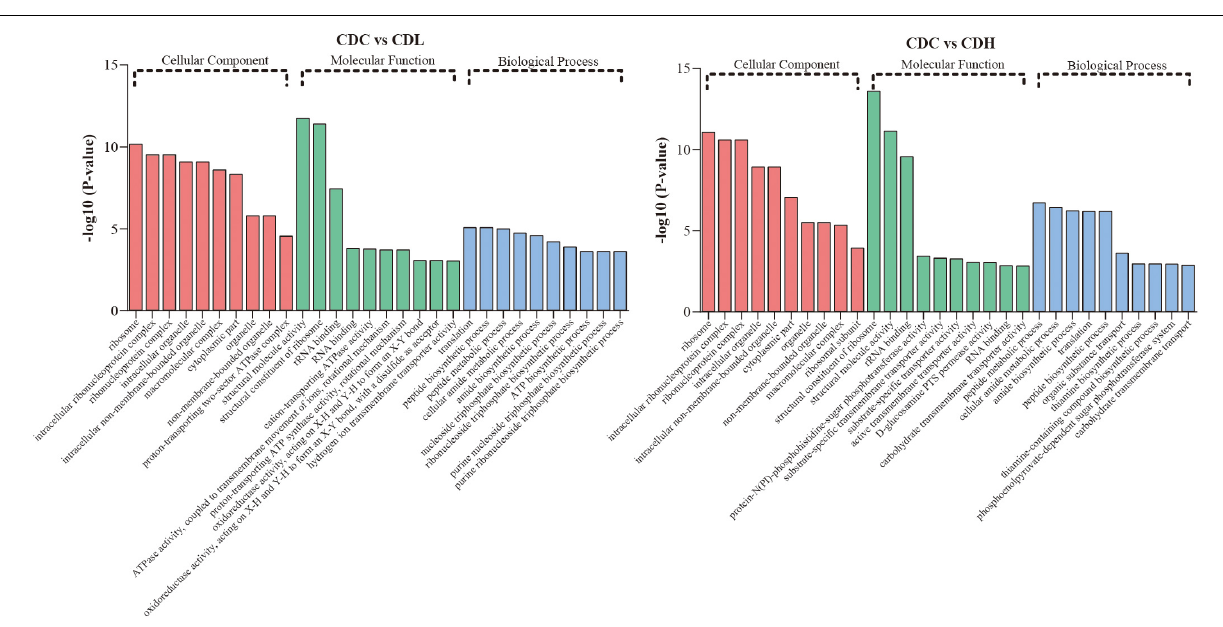
biosynthetic process, and macromolecule metabolic process,